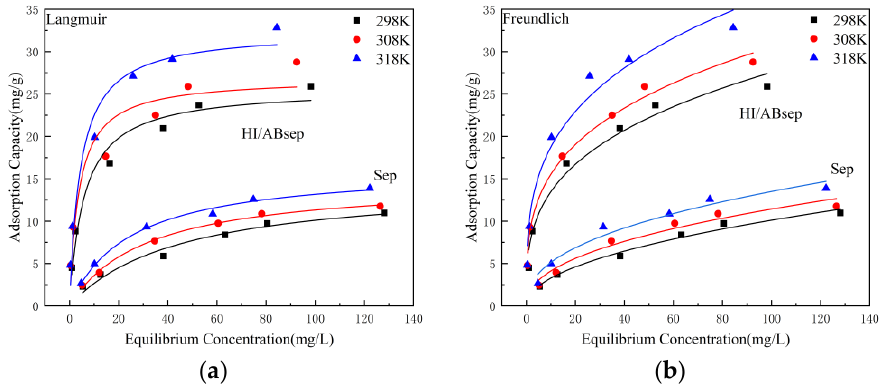
Figure 6. Isothermal adsorption line of HI/ABsep to Sb (III). ( a ). the Langermuir isotherm model for HI/ABsep adsorbed Sb (III), 298K, 308K, 318K; ( b ). the Freundlich isotherm model for HI/ABsep adsorbed Sb (III), 298K, 308K, 318K. Table 2. Two adsorption isotherm-related parameters.